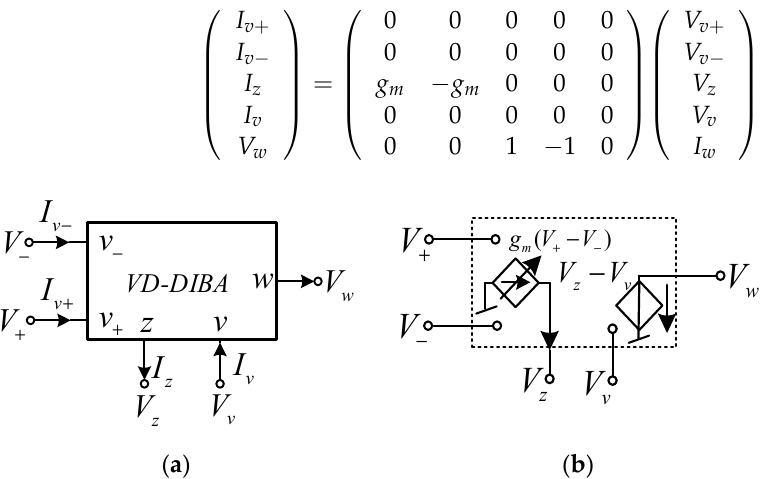
Figure 2. ( a ) The symbolic representation of the voltage differencing differential input buffered amplifier (VD-DIBA) and ( b ) VD-DIBA equivalent circuit [18].